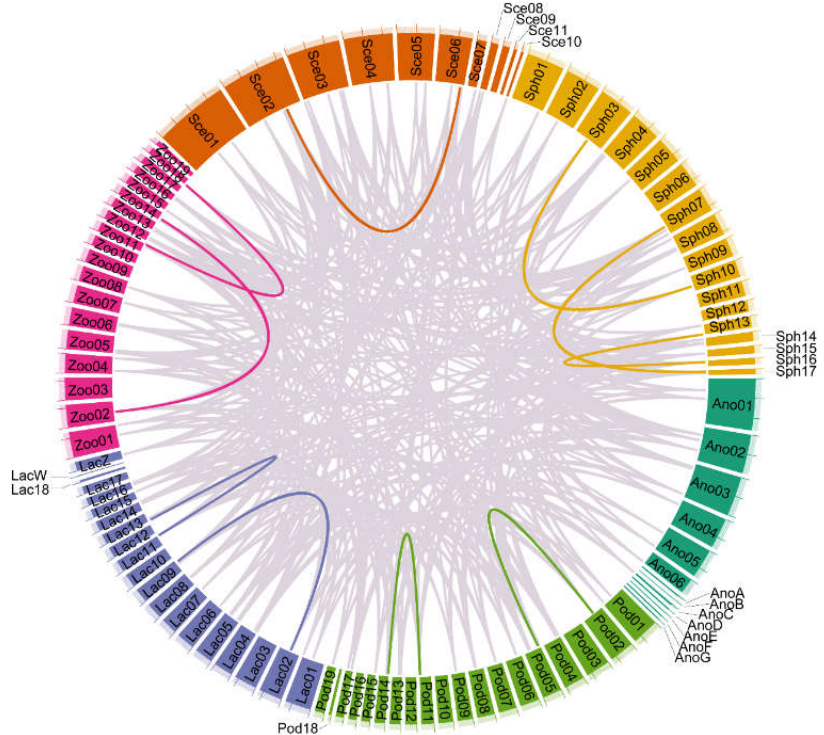
Figure 4. Colinear region of the TRP gene of saurian. The gray lines represent all the colinear blocks in TRP gene pairs among species, while the highlight-colored lines represent TRP gene pairs subjected to segmental duplication within species. Chromosome numbers are shown at the bottom of each chromosome.